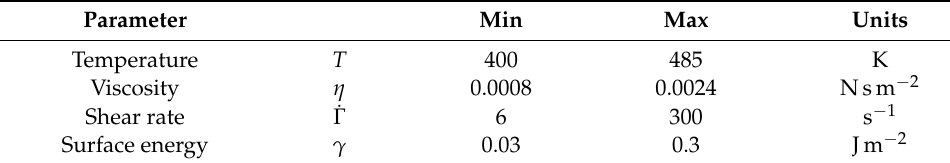
Table 1. Input process and material parameters for DEM